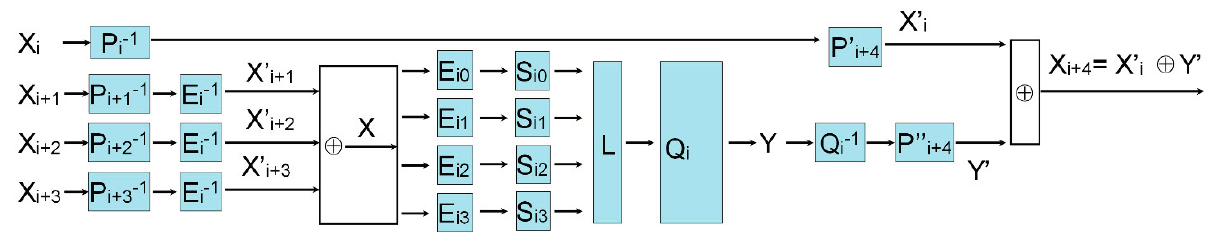
Figure 8. The structure of a round of Xiao et al .’s white-box SMS4.